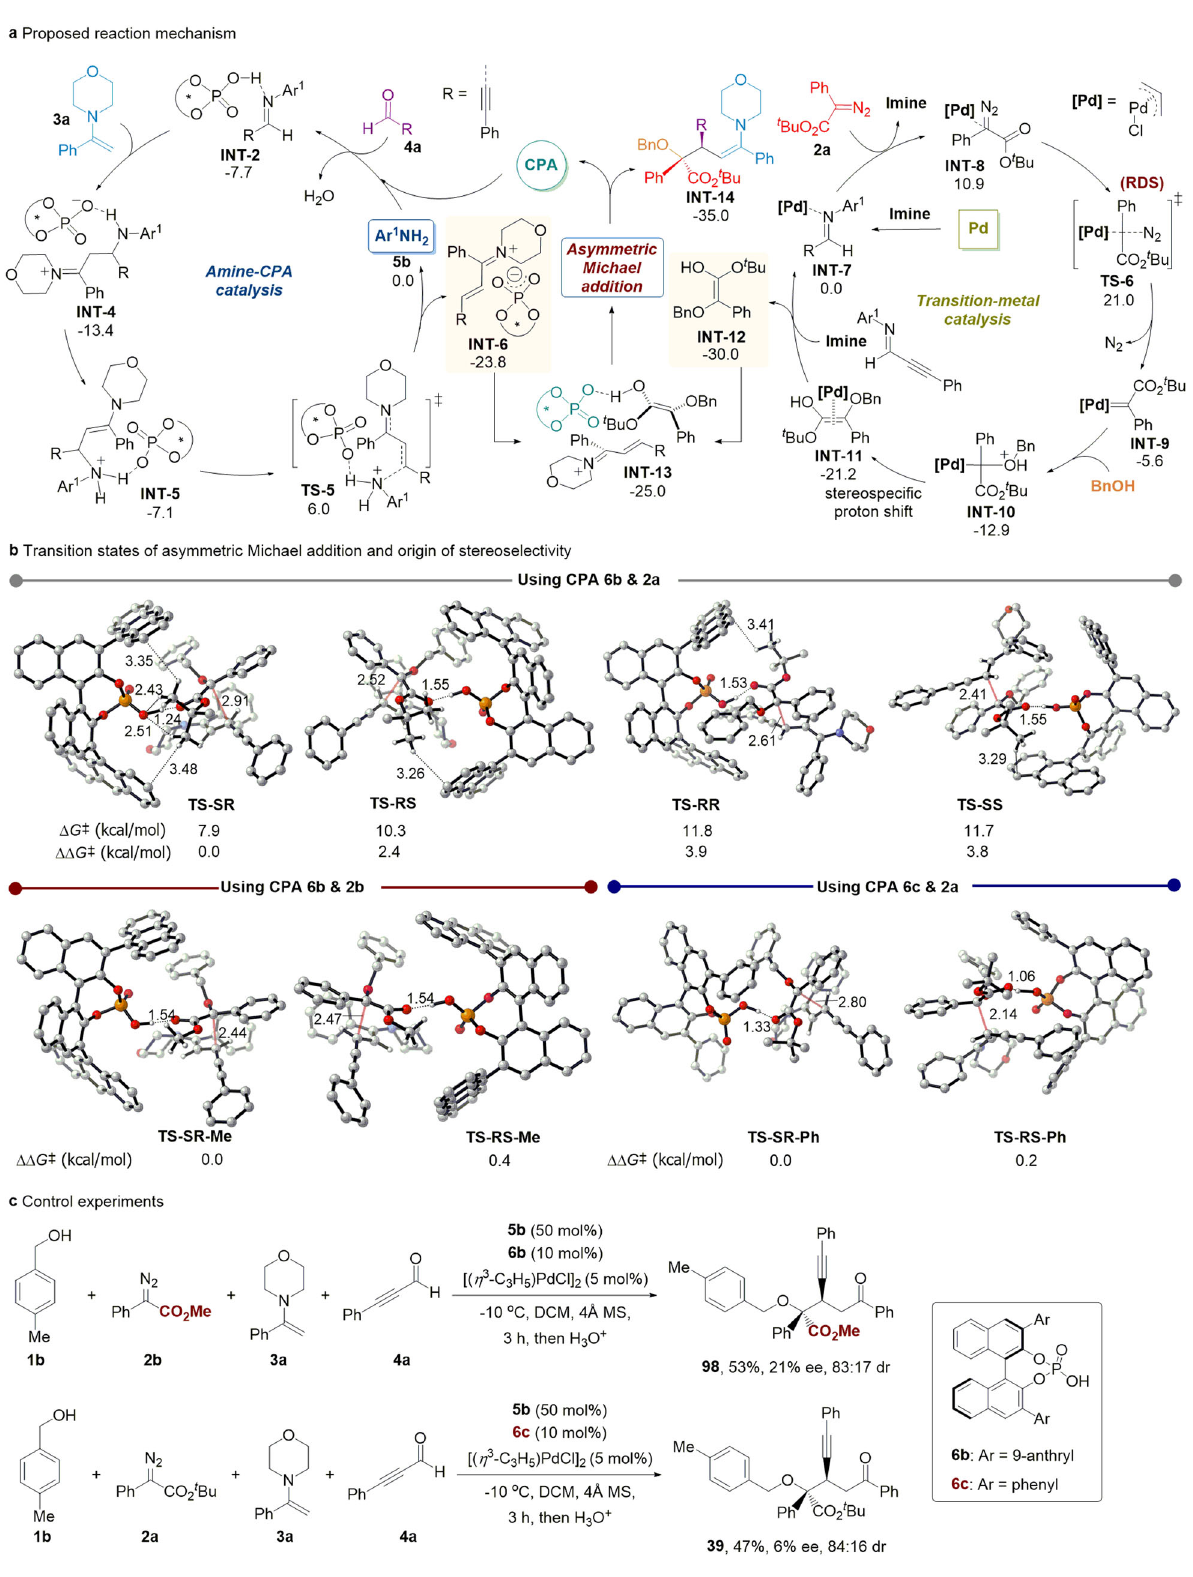
b , the Gibbs free energies were computed with CPCM(DCM)-M06-2X/6-311+G(d,p) [SDD for Pd]//CPCM(DCM)-B3LYP/6-31G(d)[LANL2DZ for Pd]. Most hydrogen atoms are omitted for clarity. All distances are in